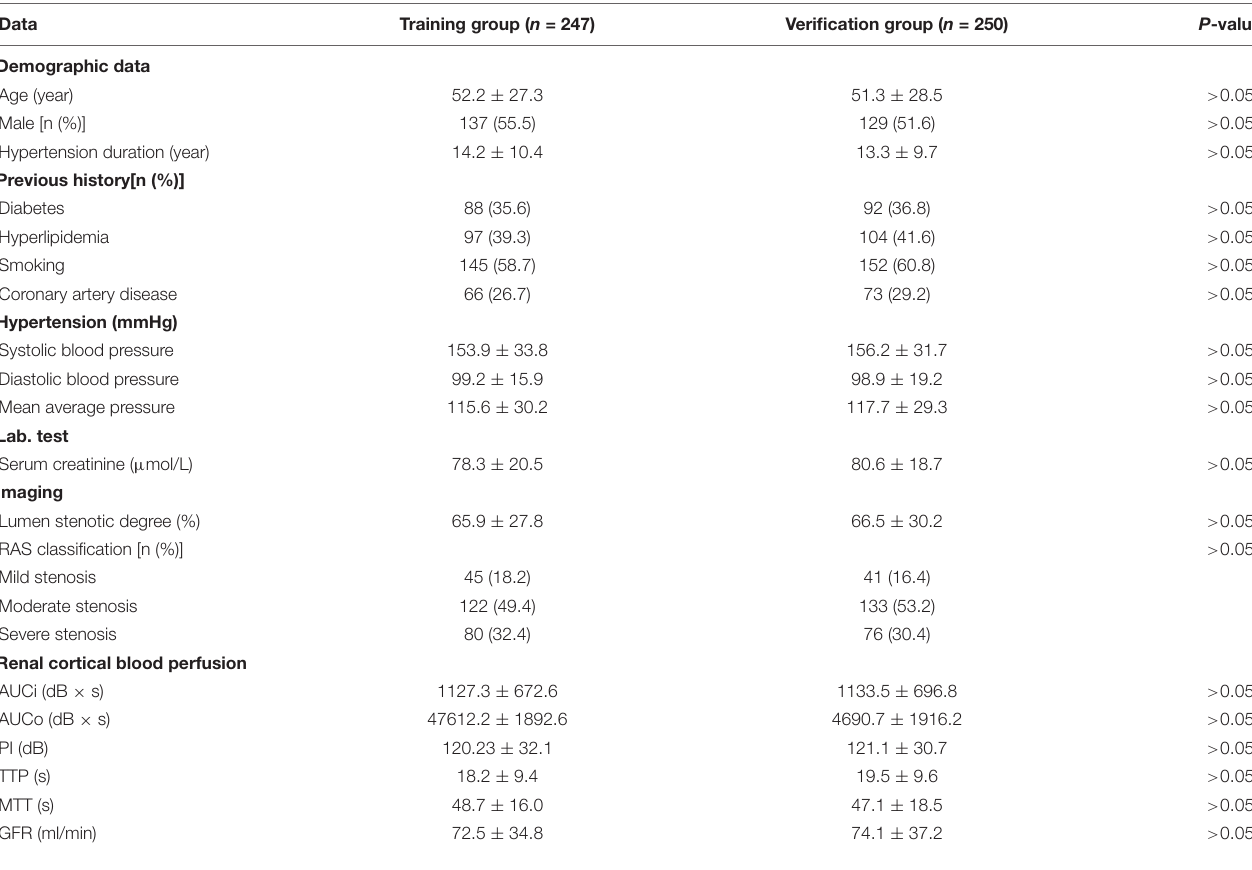
TABLE 1 | Baseline characteristics of the training group and verification